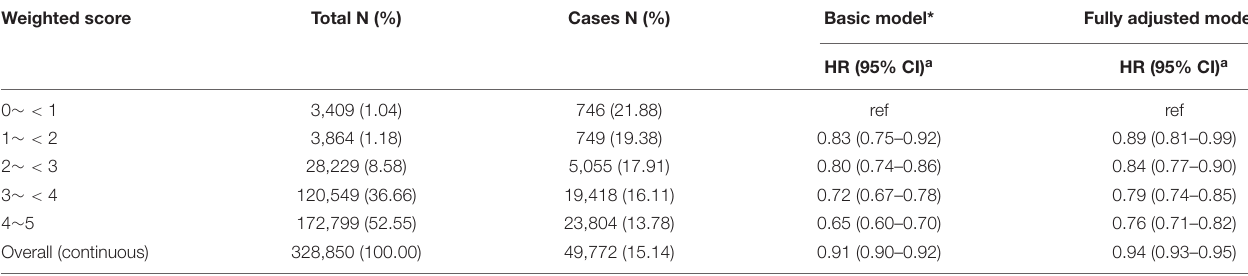
TABLE 4 | Associations for weighted sleep score with risk of terminated health span among 328,850 participants. Weighted